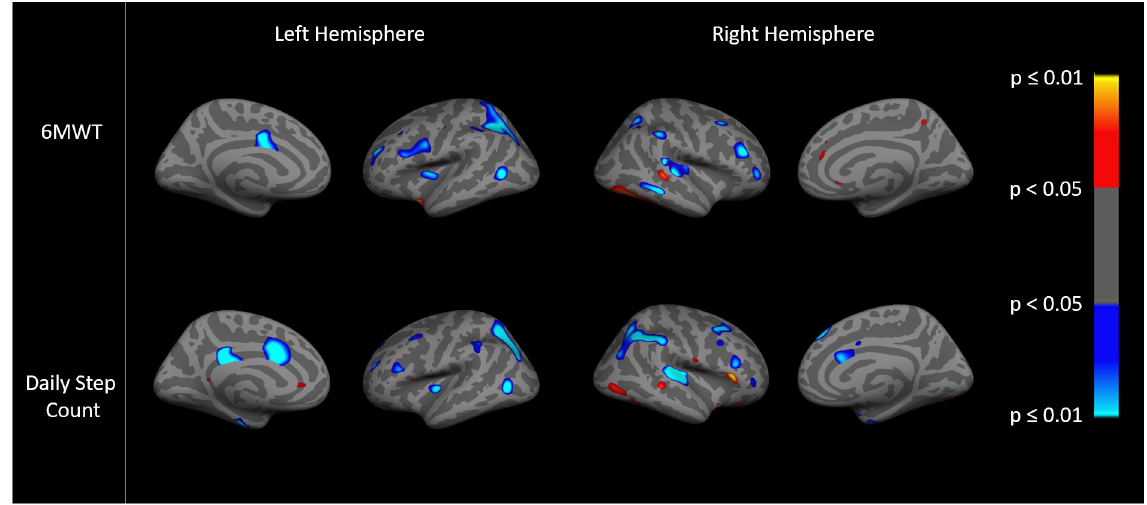
Fig 4. Association between DMN functional connectivity with exercise capacity (6MWT distance) (top) and physical activity (daily step count) (bottom).